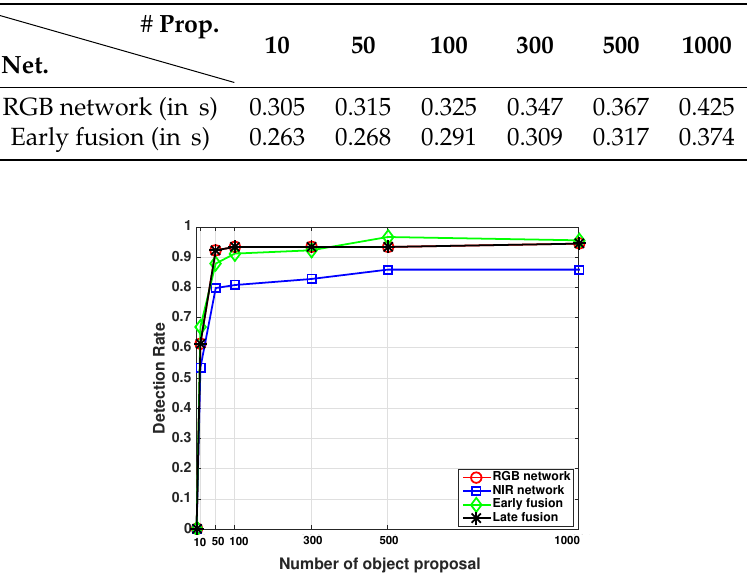
Table 4. Region proposal generating time including detection.